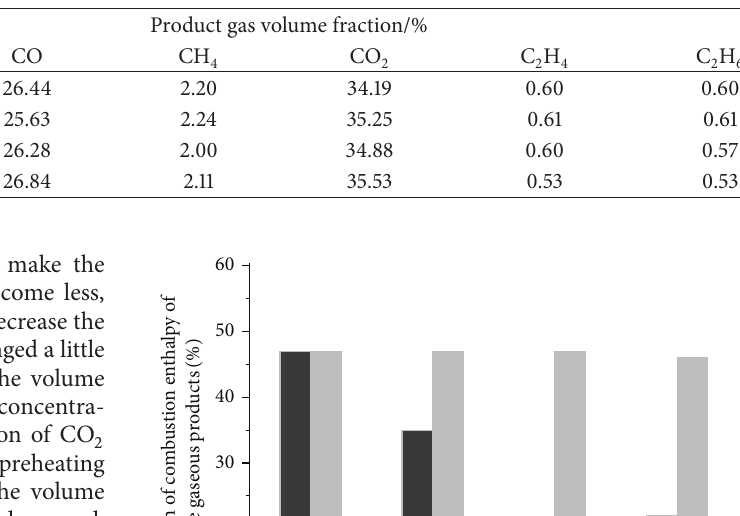
Table 2: The product gas volume fraction of different mass concentration of glucose solution gasification in SCW by Method 2 (600 ∘ C; 25 MPa).